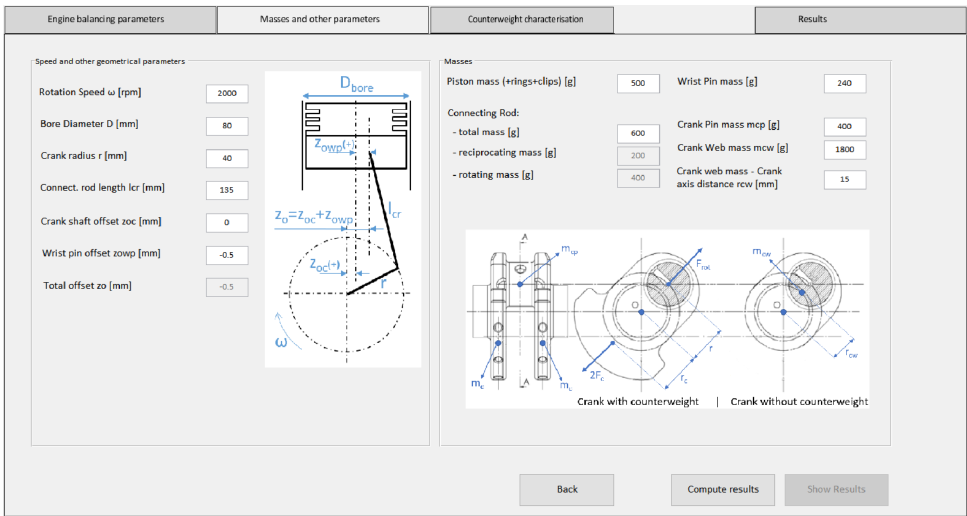
Figure 8. Tab of the user-interface devoted to the definition of the geometrical parameters and the masses of the crank